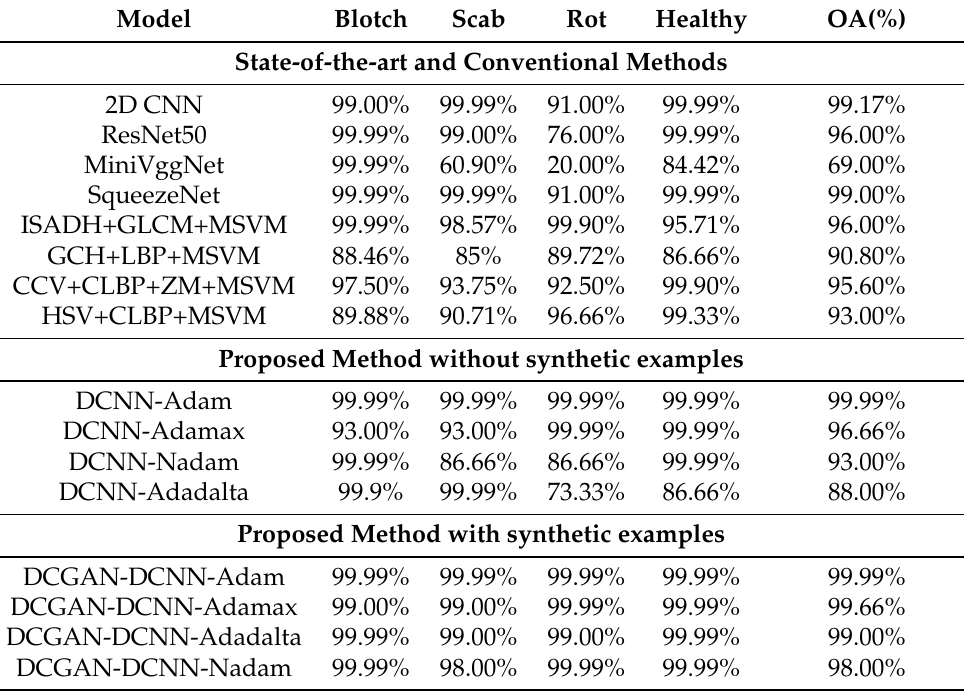
Table 2. Experimental evaluation with and without synthetic examples as compared to the state-of- the-art as well as conventional methods. The higher accuracies are in bold face.